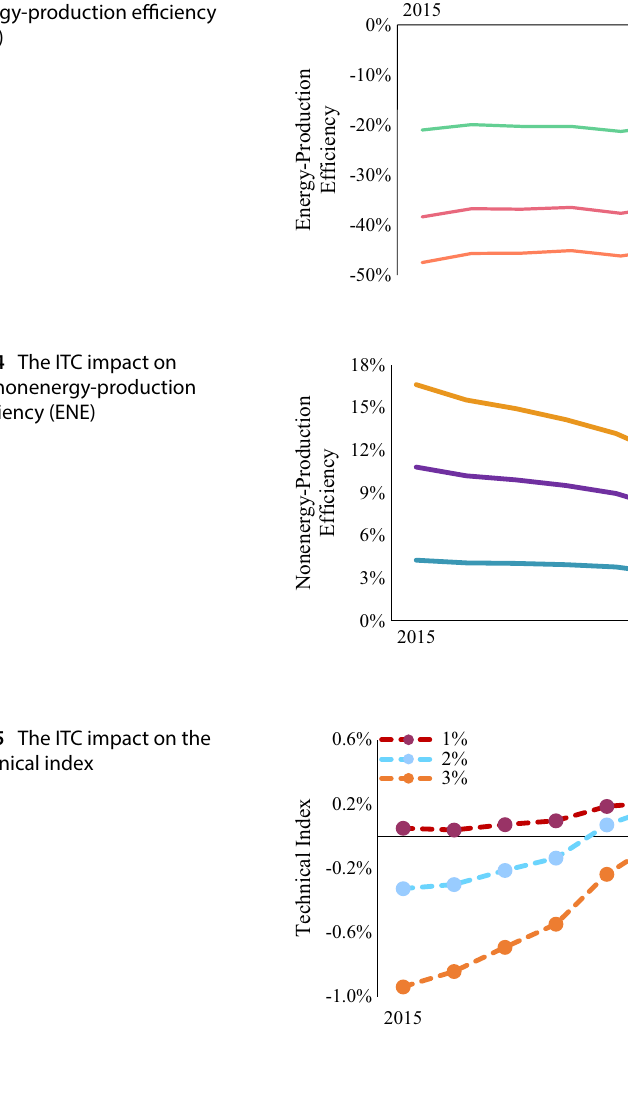
Fig. 3 The ITC impact on the energy-production efficiency